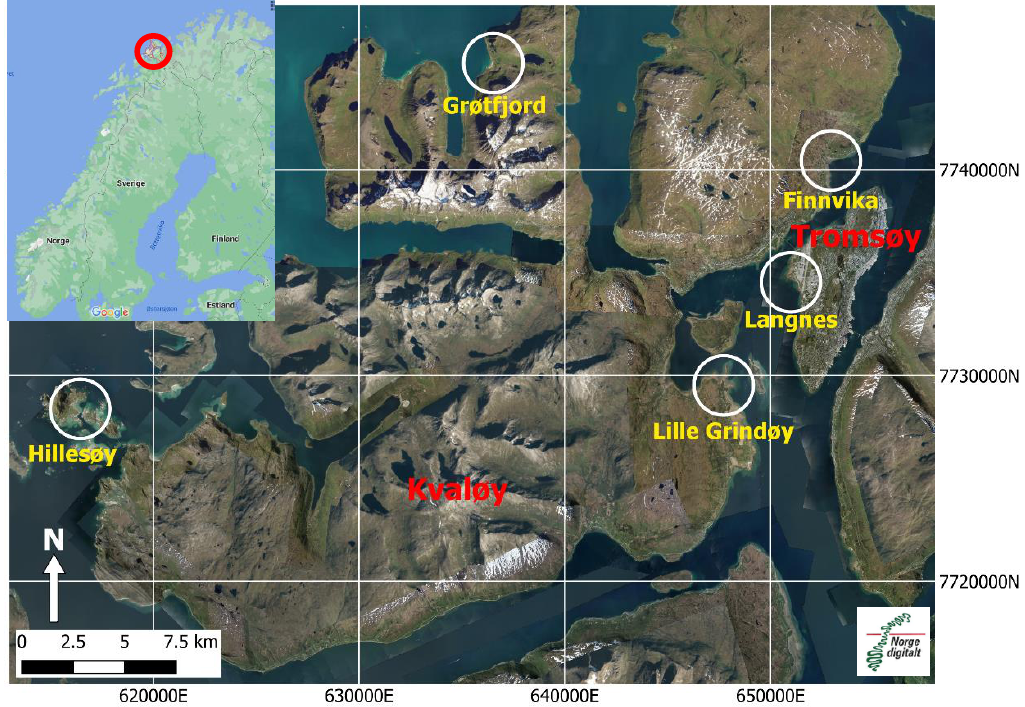
Figure 1. Location of field sites in an aerial mosaic (©Norge digitalt, norgeibilder.no) over the Tromsø Municipality in northern Norway: Langnes on Tromsøy and Lille Grindøy, Finnvika, Grøtfjord, and Hillesøy on Kvaløy. The city of Tromsø is on Tromsøy, the small island to the right in the figure. Field data sites are indicated in yellow.